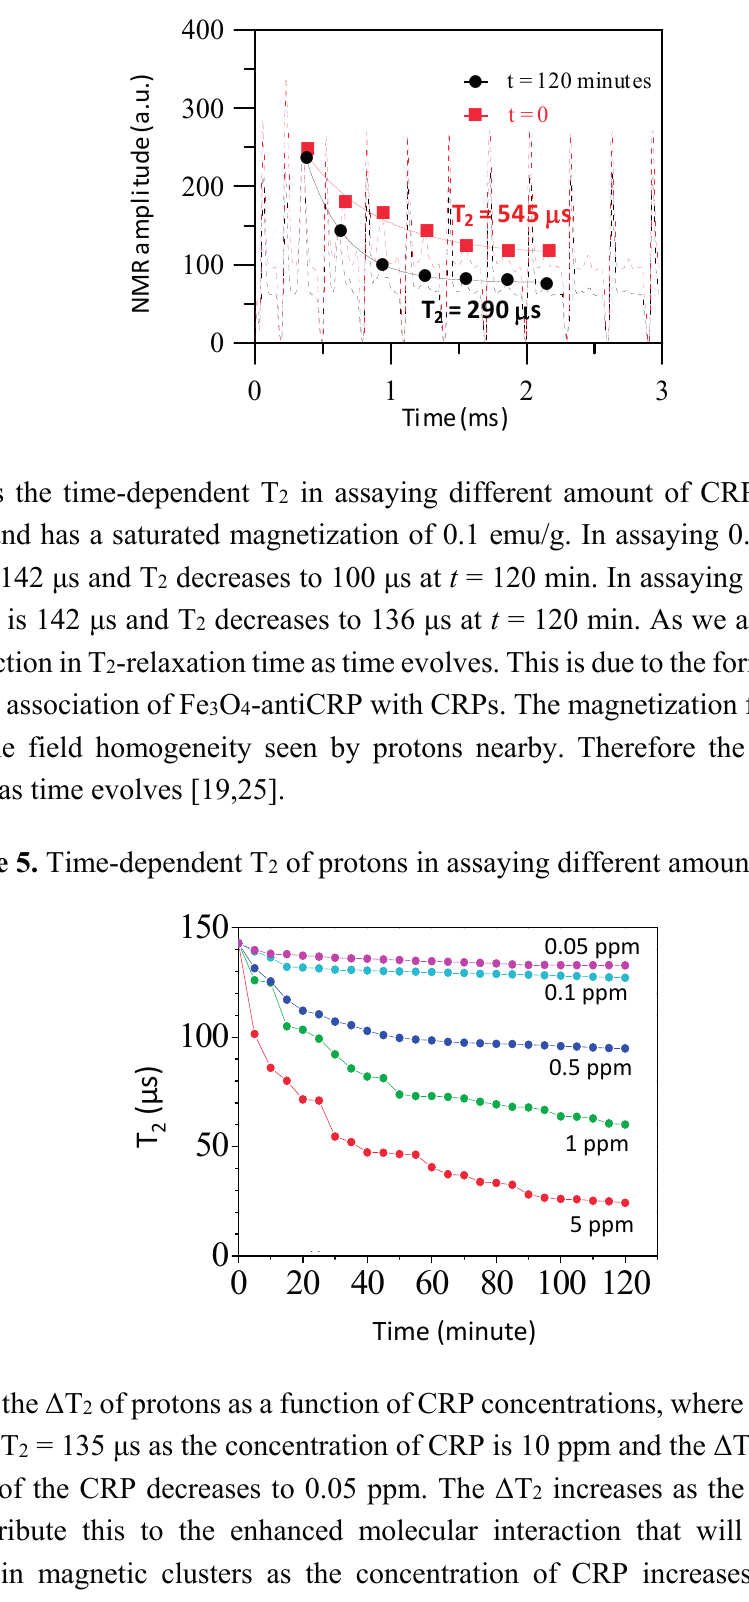
Figure 4. Spin-echo MR signals at t = 0 and t = 120 min.